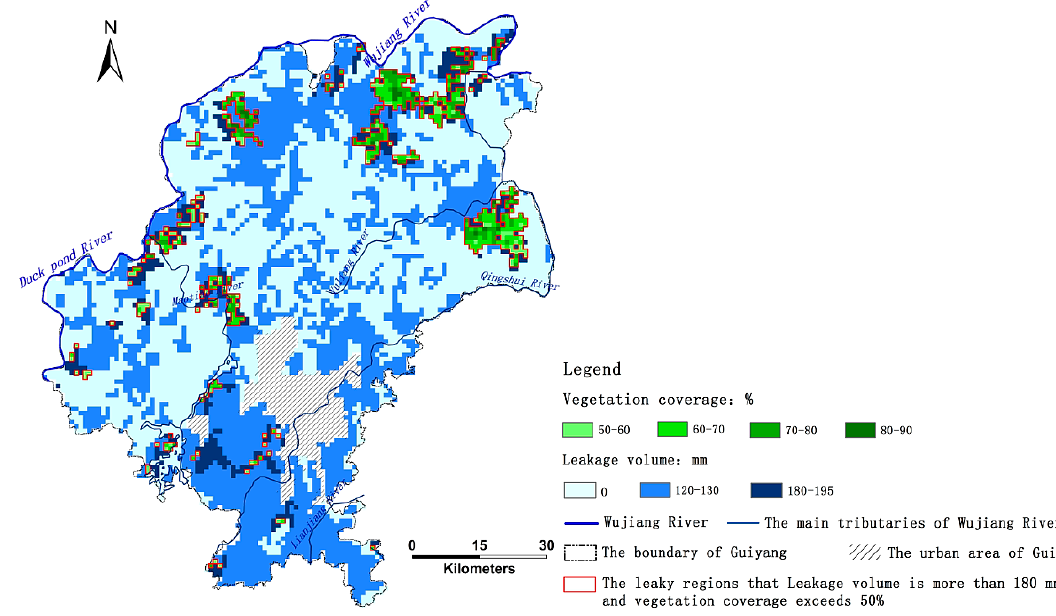
Figure 12. Leaky regions where the leakage volume is >180 mm and vegetation coverage is >50%.